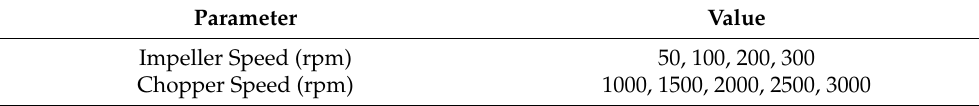
Table 4. Rotational speed